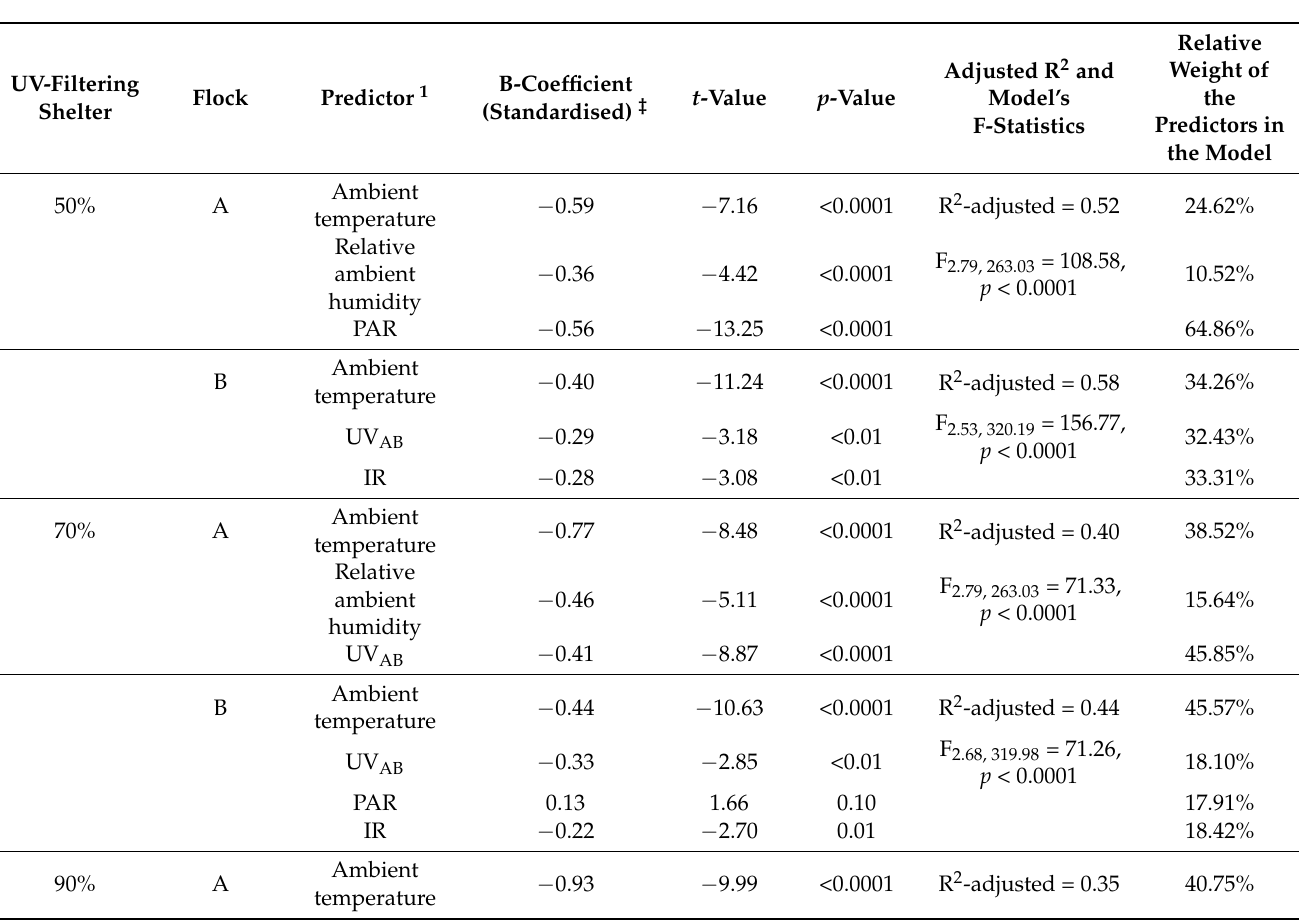
Table 2. Multiple ridge regression analyses (ridge parameter, k = 0.02) on the number of hens under different UV-filtering shelters throughout the day. Only variables that significantly contributed to the most parsimonious model are